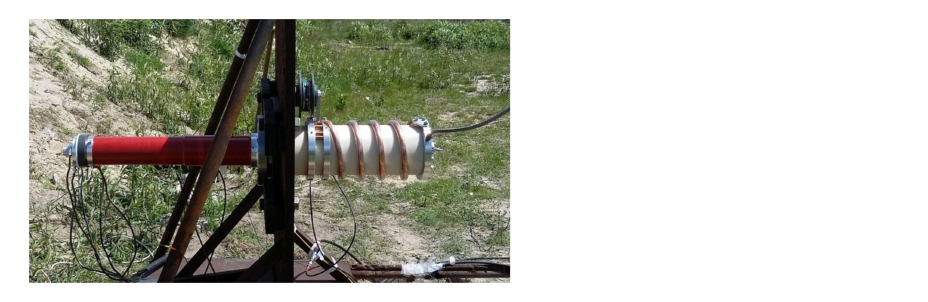
Figure 15. Photograph of the integrated high-power pulse generation and forming system field test stand with the armor plate protecting the FF and measuring transducers against FCG explosion.